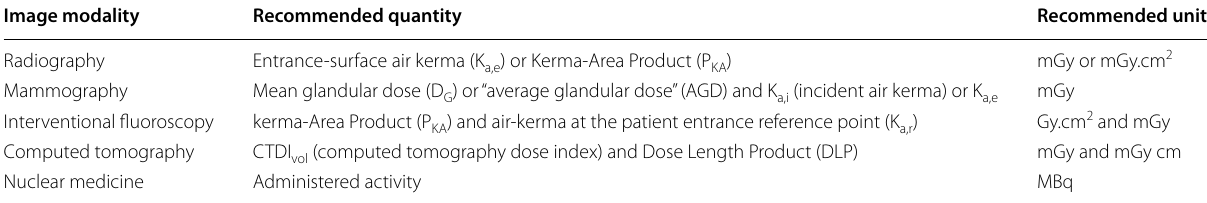
Table 1 Quantities suitable for setting diagnostic reference levels (DRLs) ICRP-135 [4] Image